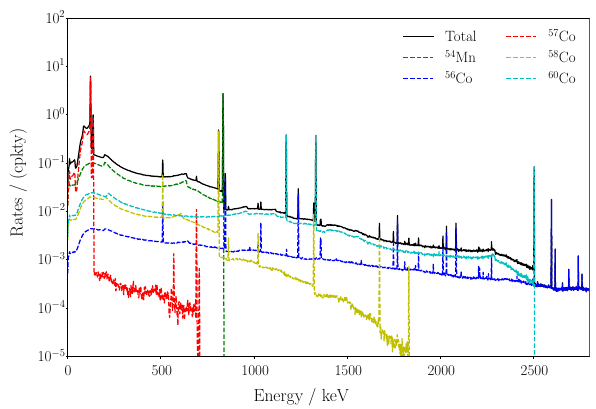
Fig. 4 Simulated cosmogenic background spectra in 0 − 2.8 MeV region from copper components of germanium detectors for CDEX- 100 experiment. Energy resolution is determined by the germanium detector used in CDEX-1B